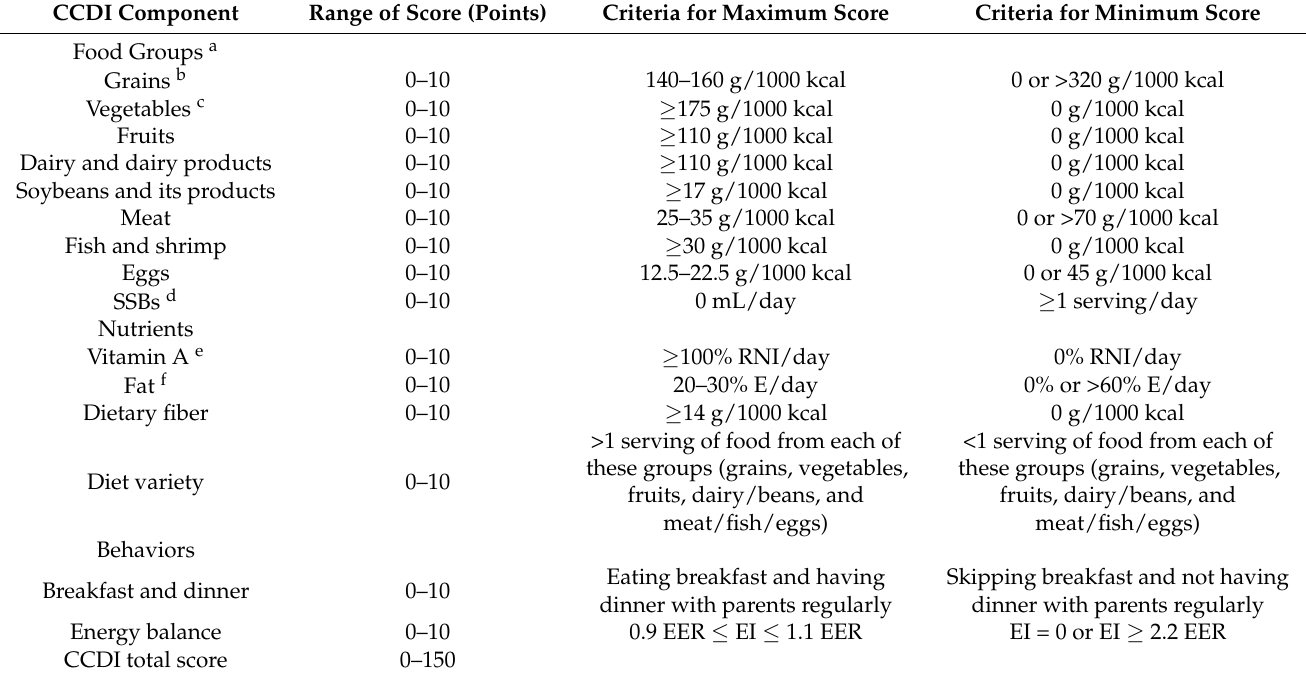
Table 1. Adjusted scoring system for the components of the CCDI, a measure of overall diet quality for Chinese school-aged